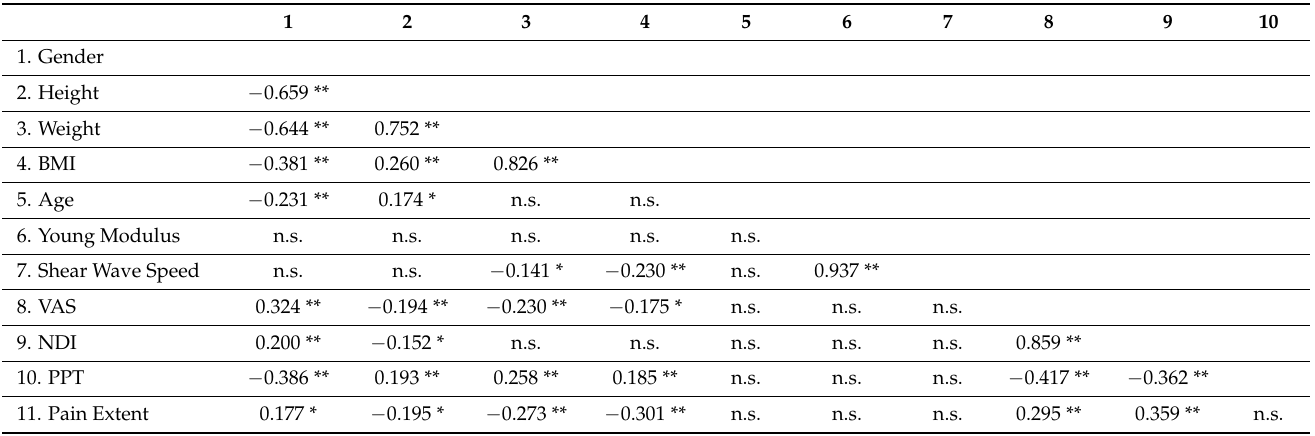
Table 4. Pearson-product moment correlation